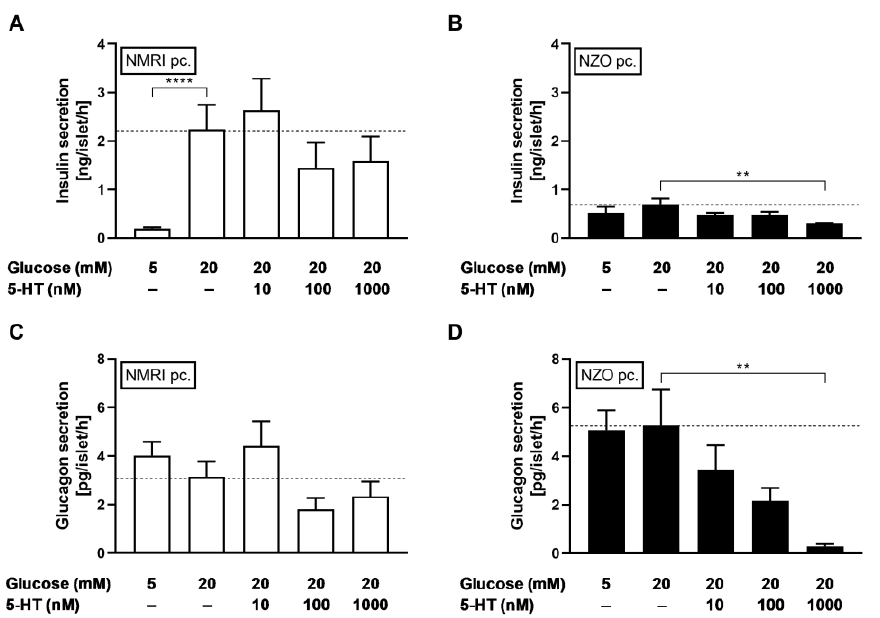
Figure 3. Decreased insulin and glucagon secretion in freshly isolated islets of Langerhans by 5-HT. Insulin (upper graphs) and glucagon secretion (lower graphs) of preconceptional ( A , C ) NMRI and ( B , D ) NZO islets after static incubation with 5, 20, and 20 mM glucose in combination with 5-HT. Data are presented as means ± SEM (( A ) n = 8–9, ( B ) n = 7–8, ( C ) n = 8–9, and ( D ) n = 7–9 animals per group). ** p < 0.01; **** p < 0.0001.